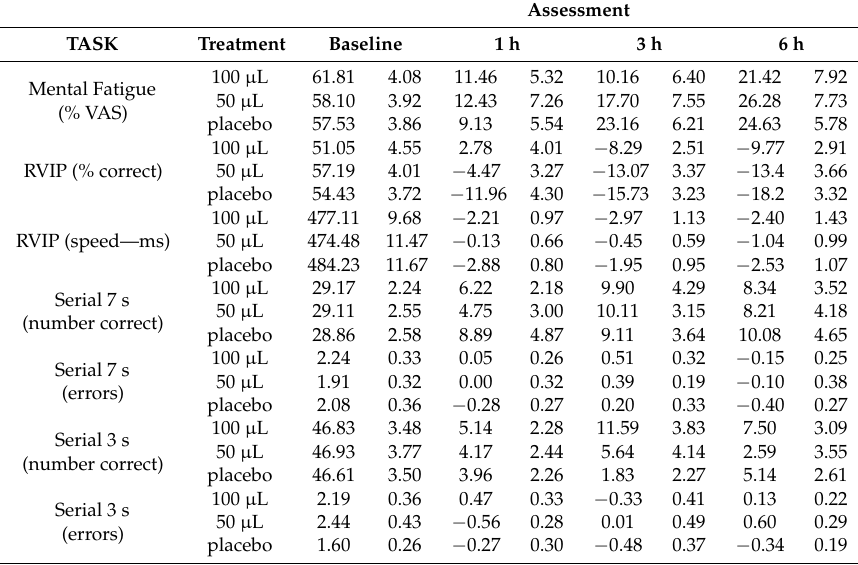
Table 2. Cognitive Demand Battery pre-dose baseline (raw) data and “% change from baseline” data for the 1 h, 3 h and 6 h assessments. Serial 3 s/7 s errors post-dose scores are “change from baseline” (due to potential zero scores). All data shown are average scores across the 4 repetitions of each task during each assessment. Scores are mean (+